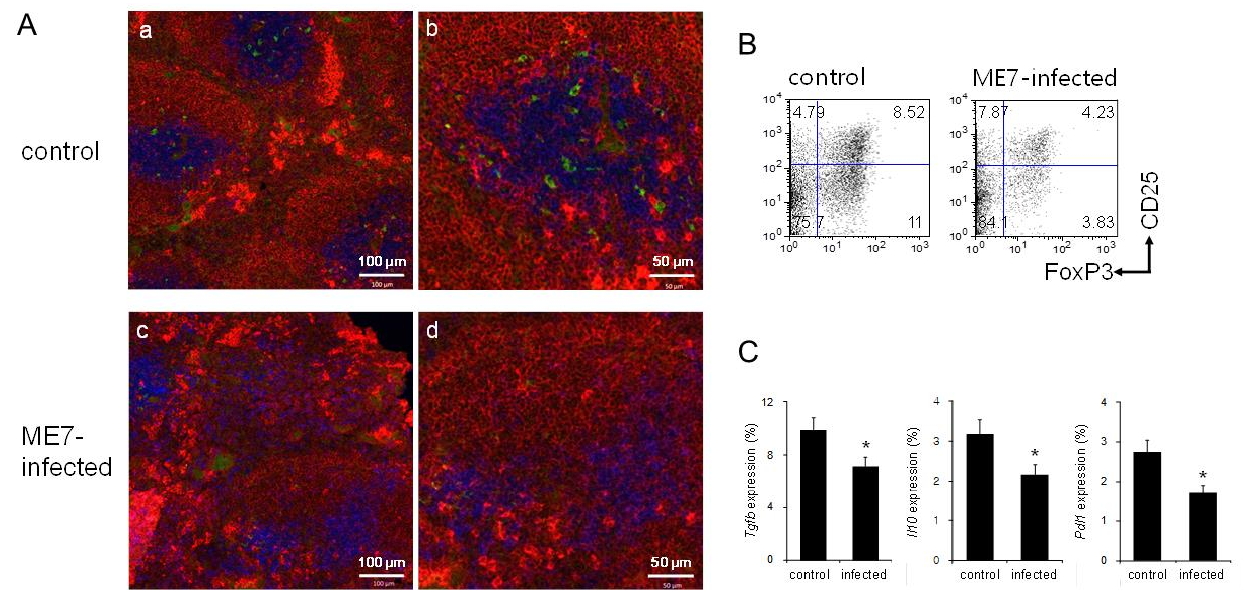
Figure 5. Analyses of FoxP3 + Treg cells from control and ME7-infected mouse spleens. ( A ) Confocal images of spleen sections: ( a , c ) Low-power images of white pulp, ( b , d ) high-power images. Immunofluorescent staining indicates CD3 (blue for T cells), IgM (red for B cells), and FoxP3 (green for Treg cells). ( a , b ) Control spleen. ( c , d ) ME7-infected spleen. Data are representative of sections from three mice per group. ( B ) Flow cytometric analyses of CD25 and FoxP3 expression by CD3 + CD4 + gated cells. ( C ) mRNA levels for Tgfb , Il10 , and Pdl1 . Relative mRNA levels were measured by quantitative real-time PCR and normalised to Actb expression (100%). Data represent the average expression of 12 mice per group. Error bars represent mean values ± standard deviation. * p < 0.05.